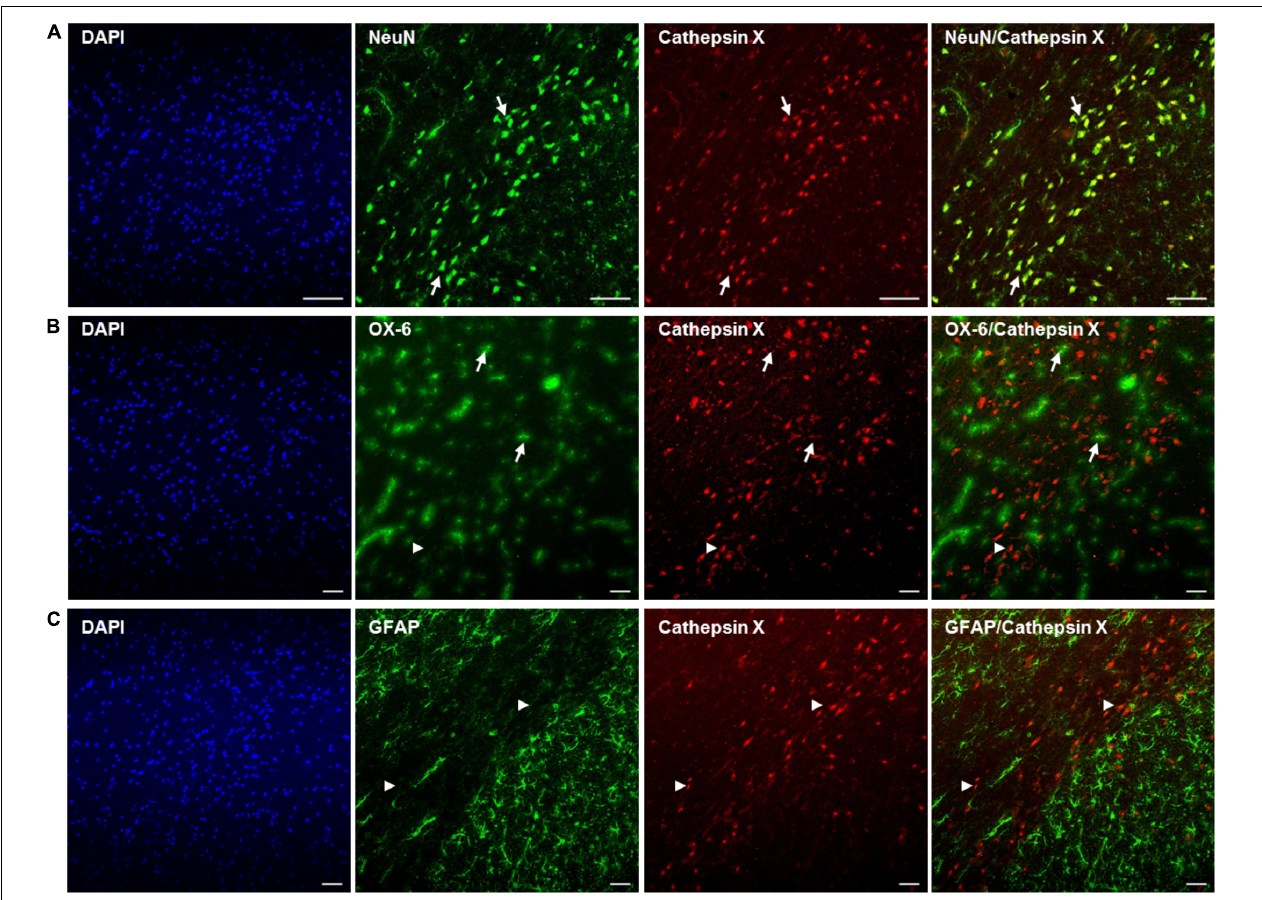
FIGURE 4 | Phenotype of increased cathepsin X-immunopositive cells in the lesioned SNc after 6-OHDA injection. Representative images of double immunofluorescence staining of cathepsin X (red fluorescence) and cell-type markers (green fluorescence) for neurons (NeuN, A ), microglial cells (OX-6, B ) and astrocytes (GFAP, C ) in the ipsilateral SNc at 12 h after the injection of 6-OHDA. Nuclei were counterstained with DAPI (blue fluorescence). Expression of cathepsin X in the lesioned SNc is predominantly restricted to NeuN-positive neuronal cells [ (A) arrows]. A single cathepsin X-positive microglial cell in the SNc was notable ( B , arrows), while most microglial cells were negative for cathepsin X (arrowheads). No astrocytes were positive for cathepsin X ( C , arrowheads). Groups of four animals ( n = 4) were analyzed and four sections of the SNc region of each animal were analyzed. Scale bar = 100 µ